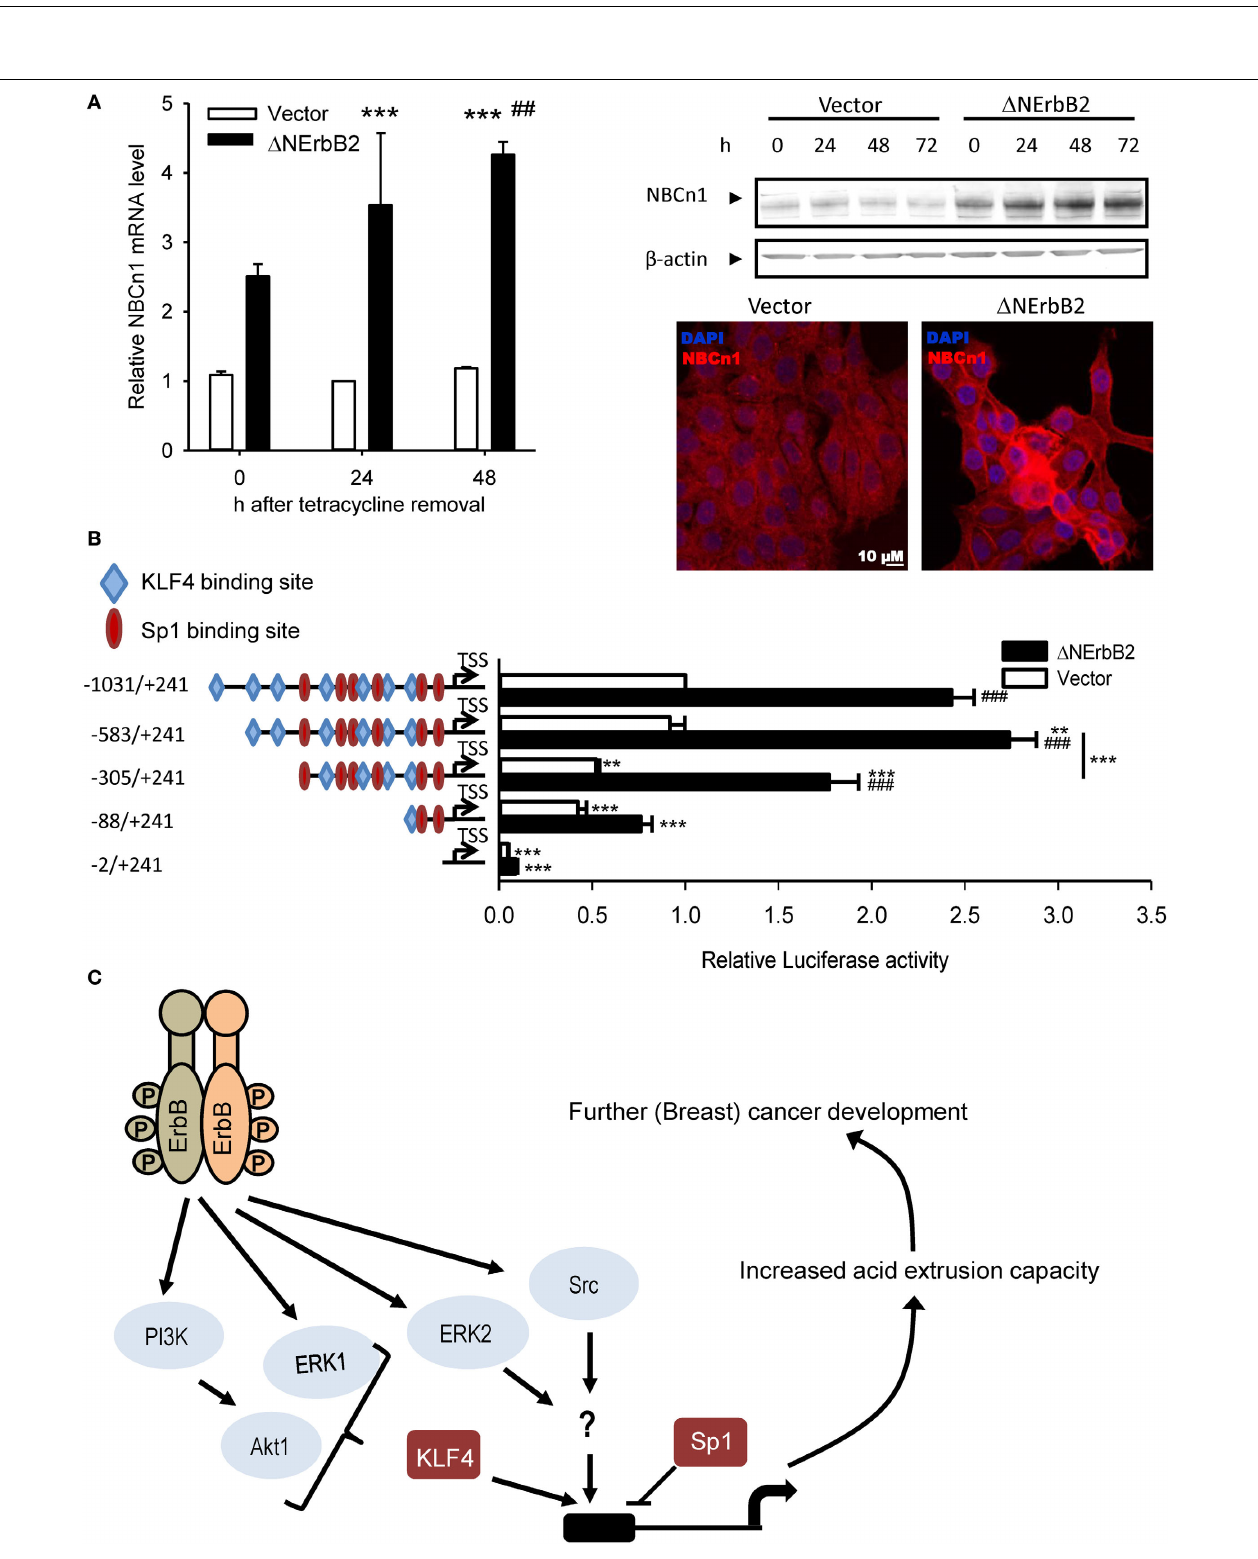
FIGURE 2 | SLC4A7 expression regulation by the truncated ErbB2 receptor. (A) SLC4A7 mRNA and protein levels. MCF-7 cells with a stably cloned N-terminally truncated ErbB2 receptor under control of a tetracycline-off promoter (MCF-tTA- (cid:2) NErbB2; here referred to as (cid:2) NErbB2 cells) and corresponding vector controls (MCF-tTA-pTRE; referred to as vector cells) were used. At given time points, after tetracycline removal, cells were